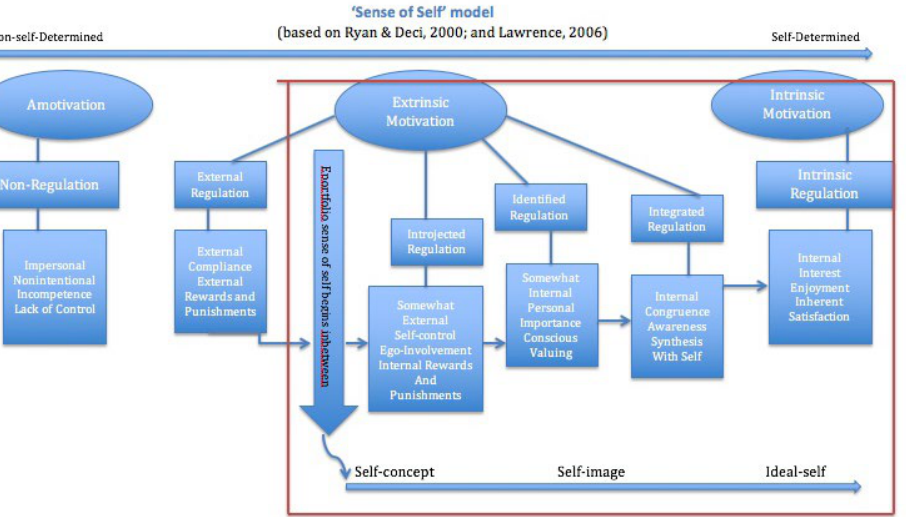
Figure 2. Sense of Self Model (Rowley & Munday,